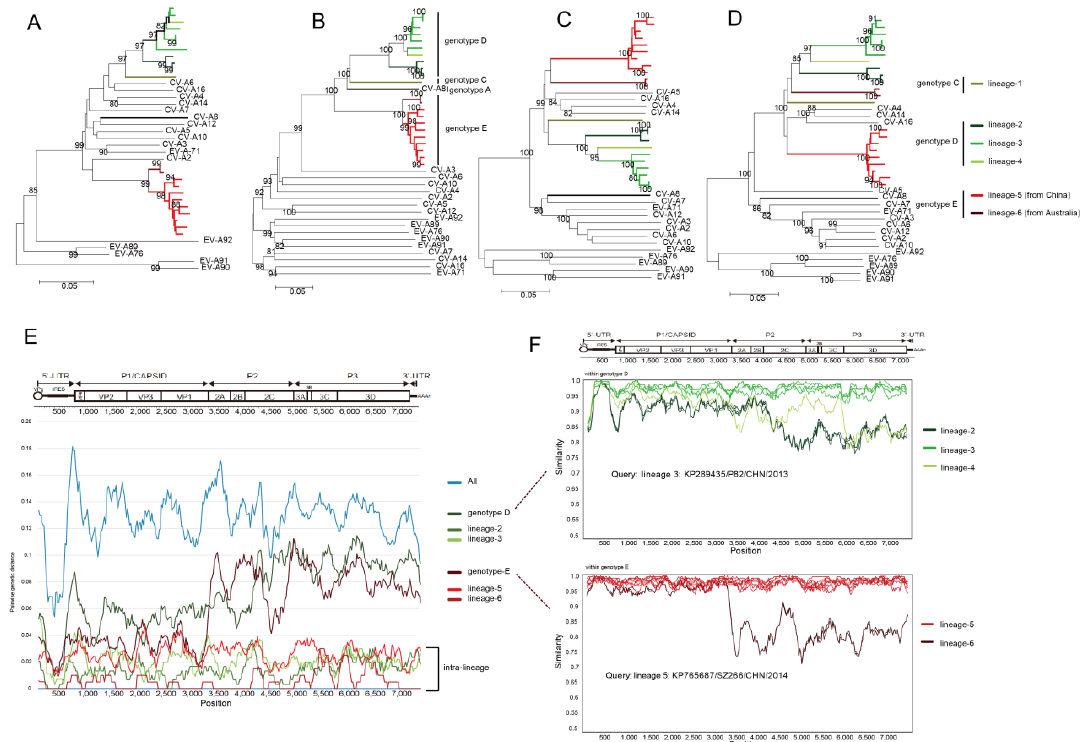
Figure 3. Neighbour-joining phylogenetic trees of 23 CV-A8 variants combined with EV-A prototype strains constructed based on the ( A ) 5′-untranslated region, ( B ) P1 capsid region, ( C ) P2 non-capsid region and ( D ) P3 non-capsid region. The recombinant lineages are differentiated by distinct colours, and each genotype is indicated on the right side of the P1 tree. ( E ) Average pairwise diversity based on 23 whole genomes of all genotypes, genotypes D and E each, and the intra-genotype recombinant lineage each, using a sliding window of 200 nt with a step of 20 nt. ( F ) Recombination breakpoints based on the whole genomes of different lineages as detected within genotypes ( D , E ).